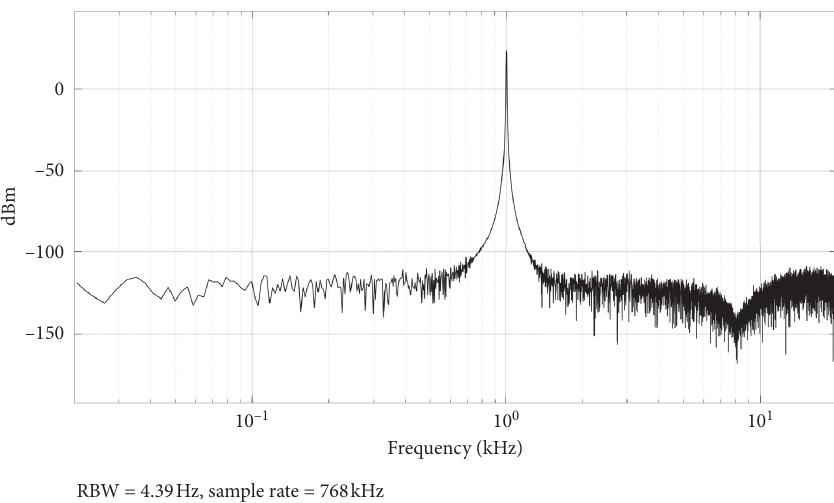
Figure 6: Output spectrum of the ΔΣ modulator.